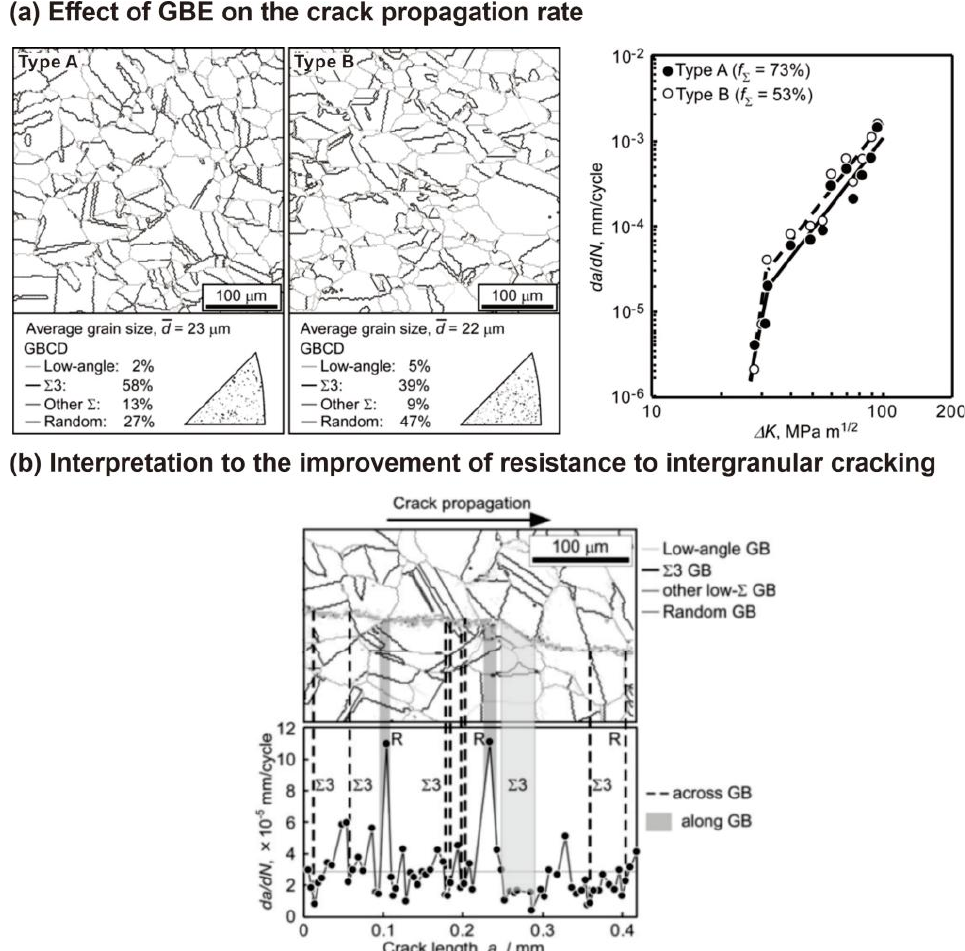
steel. ( a ) Comparisons of GBCD and crack propagation rates of Type A and Type B samples ( b